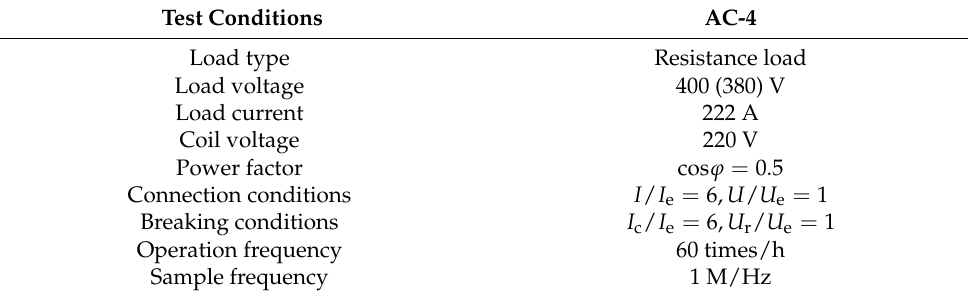
Table 1. Test parameters of